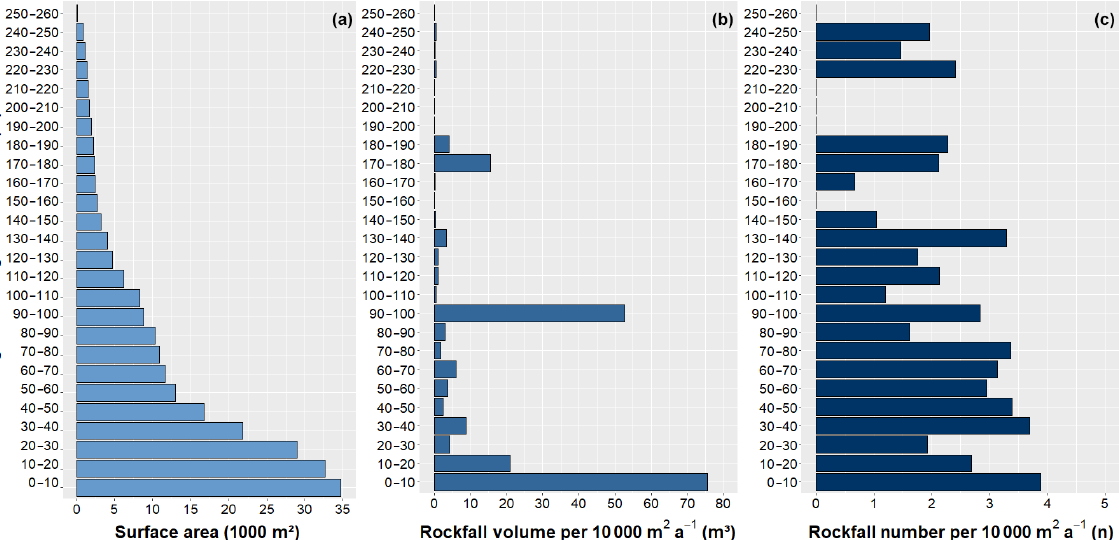
Figure 11. (a) Rockwall surface area, (b) normalized rockfall volume and (c) normalized number of rockfalls, all classified by height above glacier surface. Areas exposed by recent glacier retreat are heavily susceptible to rockfall. During the observation period (2011–2017), 60% of the total rockfall volume detached within 10m of the current glacier surface; 75% detached within